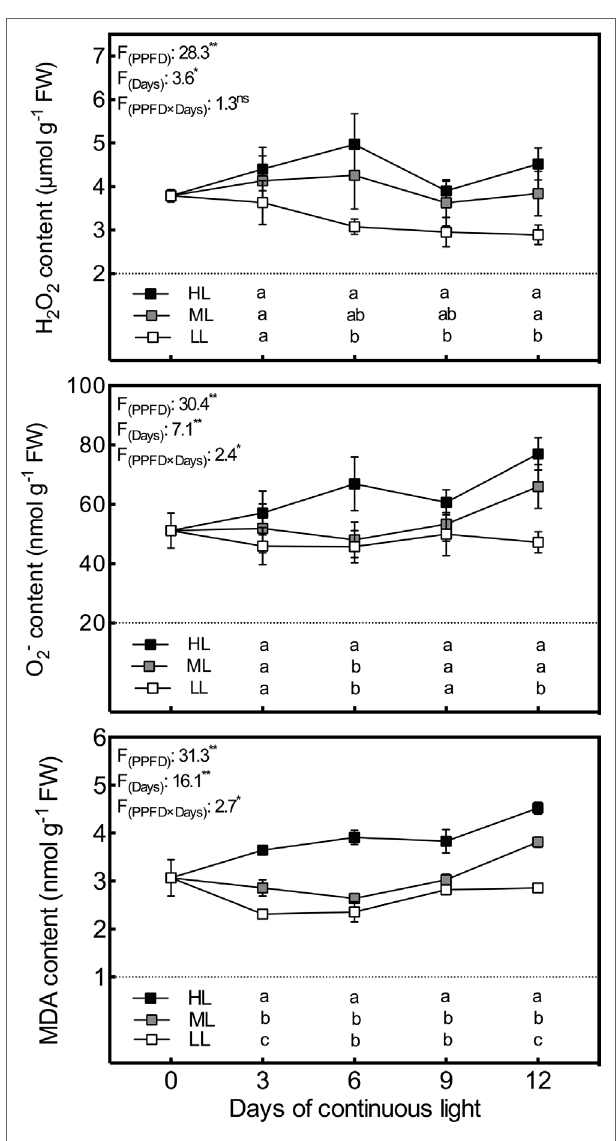
FIgURe 1 | Changes in H 2 O 2 , O 2•− , and MDA contents in lettuce leaves grown under continuous light of different intensities: low light (LL, 100